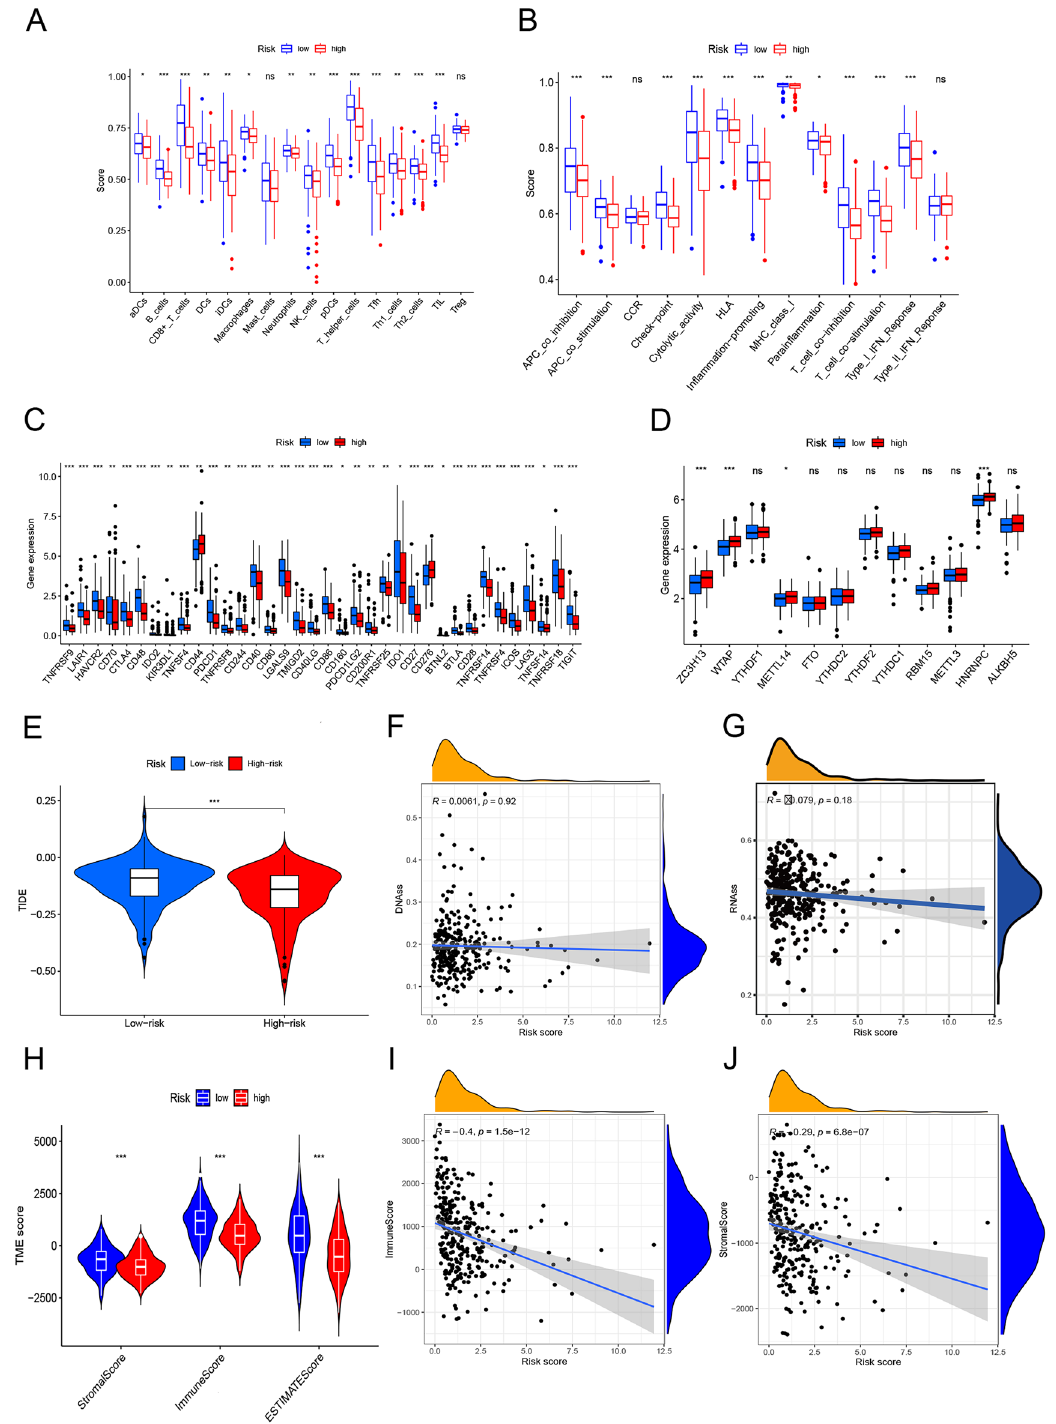
Figure 12. Immune correlation analysis. Boxplots of immune cell ( A ) and immune-related function ( B ) scores in the two risk subgroups. The differential expression based on the immune checkpoints ( C ), m6A-related genes ( D ) and TIDE scores ( E ) between the low-risk and high-risk groups. ( F – G ) Correlation between the risk scores and stem cells. ( H ) Violin plots show that the proportion of TIME scores vary between the high-risk and low- risk groups. ( I – J ) Correlation among the immune cells, stromal cell scores and risk